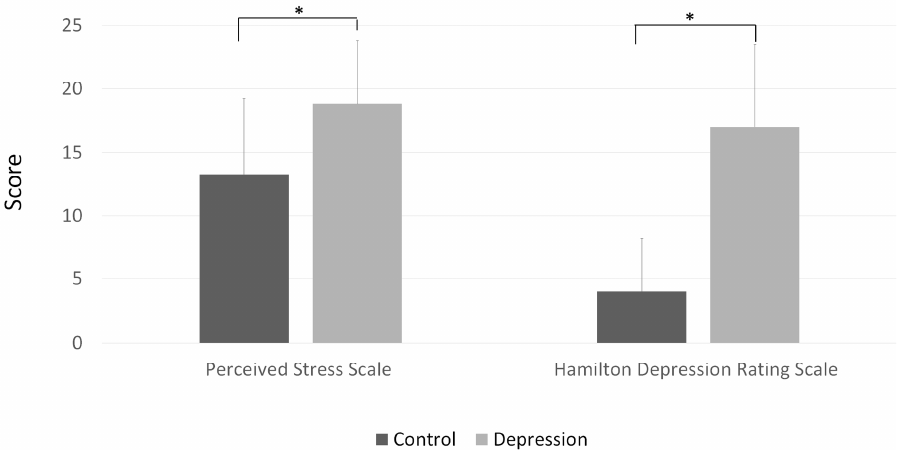
Figure 1. Perceived Stress Scale (PSS)-10 and Hamilton Depression Rating Scale (HDRS). A higher total score on the PSS-10 was recorded in the depression group than in the control group ( p < 0.001). Patients with major depressive disorder also presented higher HDRS scores than the control subjects ( p < 0.001).